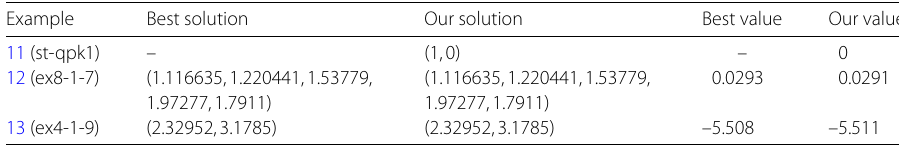
Table 3 Results of numerical experiments (Examples 11–13)